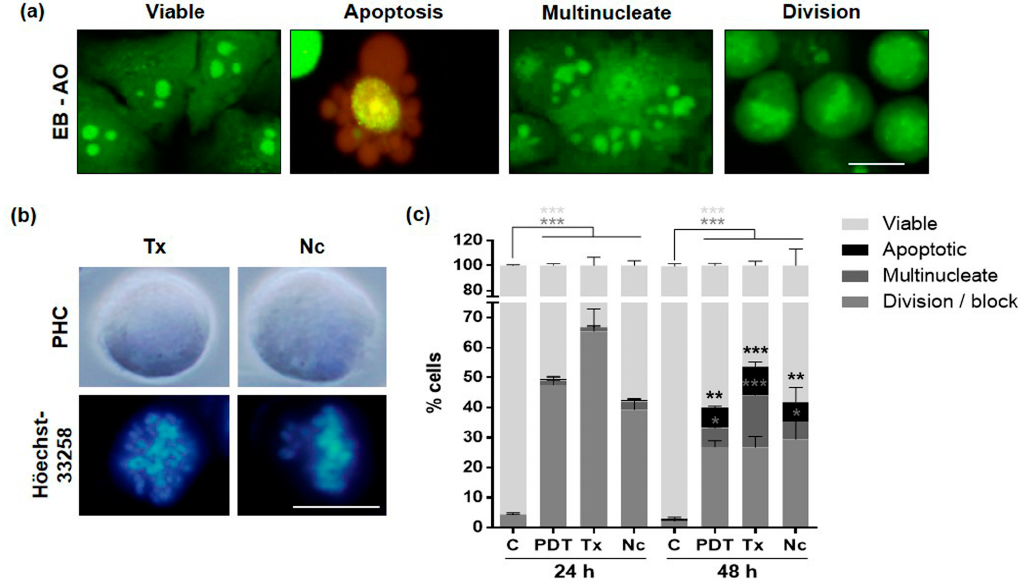
Figure 4. Morphology classification after fluorochome staining. ( a ) In vivo analysis 24 h after MAL-PDT by fluorescence microscopy after ethidium bromide (EB)-acridine orange (AO) staining. This staining allows differentiating between: (1) viable (fluorescing in green due to AO) (2) apoptotic (fluorescing in red/yellowish due to AO/EB), (3) multinucleate, and (4) dividing cells. ( b ) Cellular and nuclear morphology 24 h after treatment with 0.05 µ M Tx or 0.25 µ M Nc observed by PHC or Höechst-33258. ( c ) Percentage of viable, dividing, apoptotic and multinucleated cells 24 and 48 h after treatments application (values relative to control cells) (* p < 0.05; ** p < 0.01; *** p < 0.001). C: Control; Tx: taxol; Nc: nocodazole. Scale bar: 10 µm.